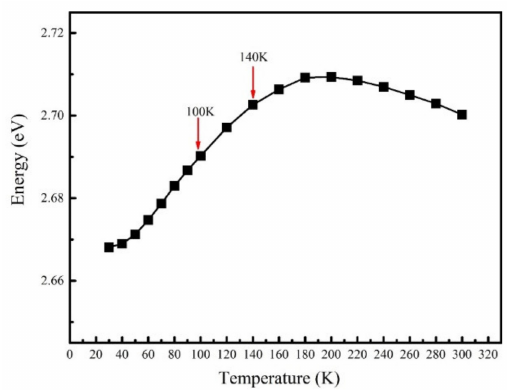
Figure 2. The PL emission peak energy as a function of temperature for sample